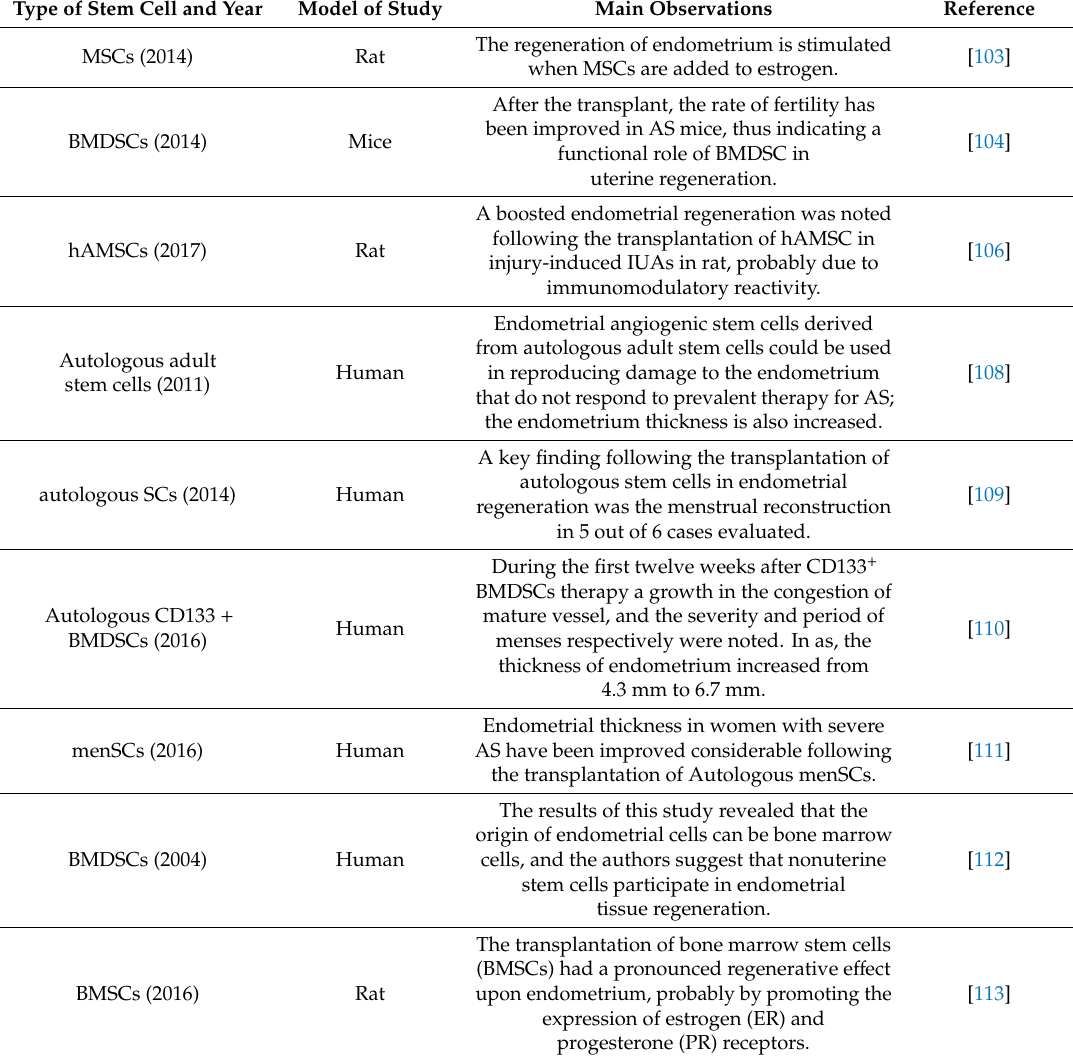
Table 4. Summary of the actions in the field of regenerative medicine and cell